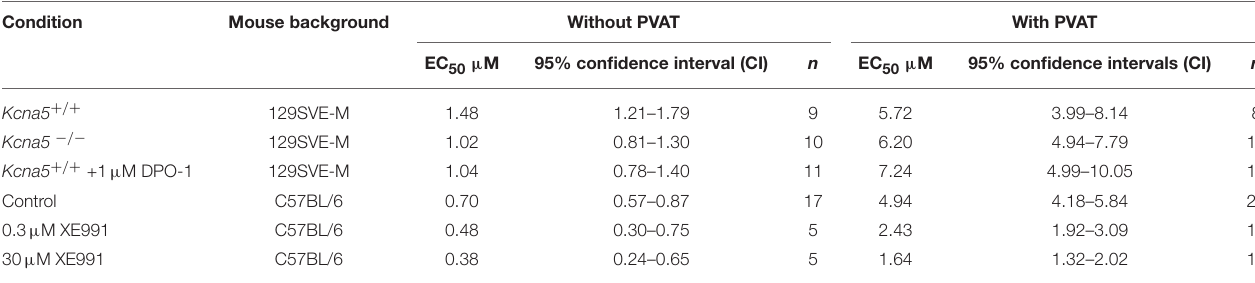
TABLE 1 | EC 50 and its confidence intervals.